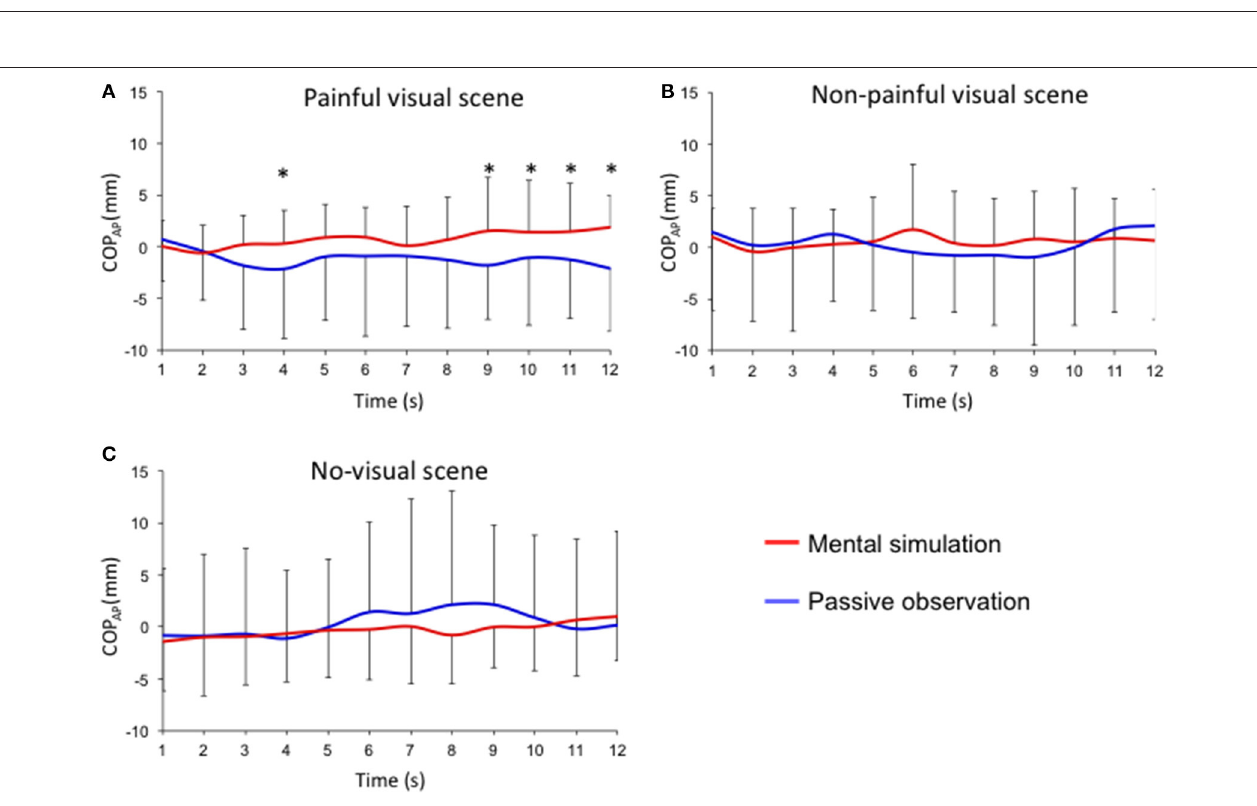
FIGURE 2 | Time-course of the anteroposterior position of the COP AP for each experimental condition (mental simulation vs. passive observation conditions). Mean sliding window (1s) for the three experimental conditions defined by the presentation of (A) painful visual scene; (B) non-painful visual scene; (C) no visual scene. * p <